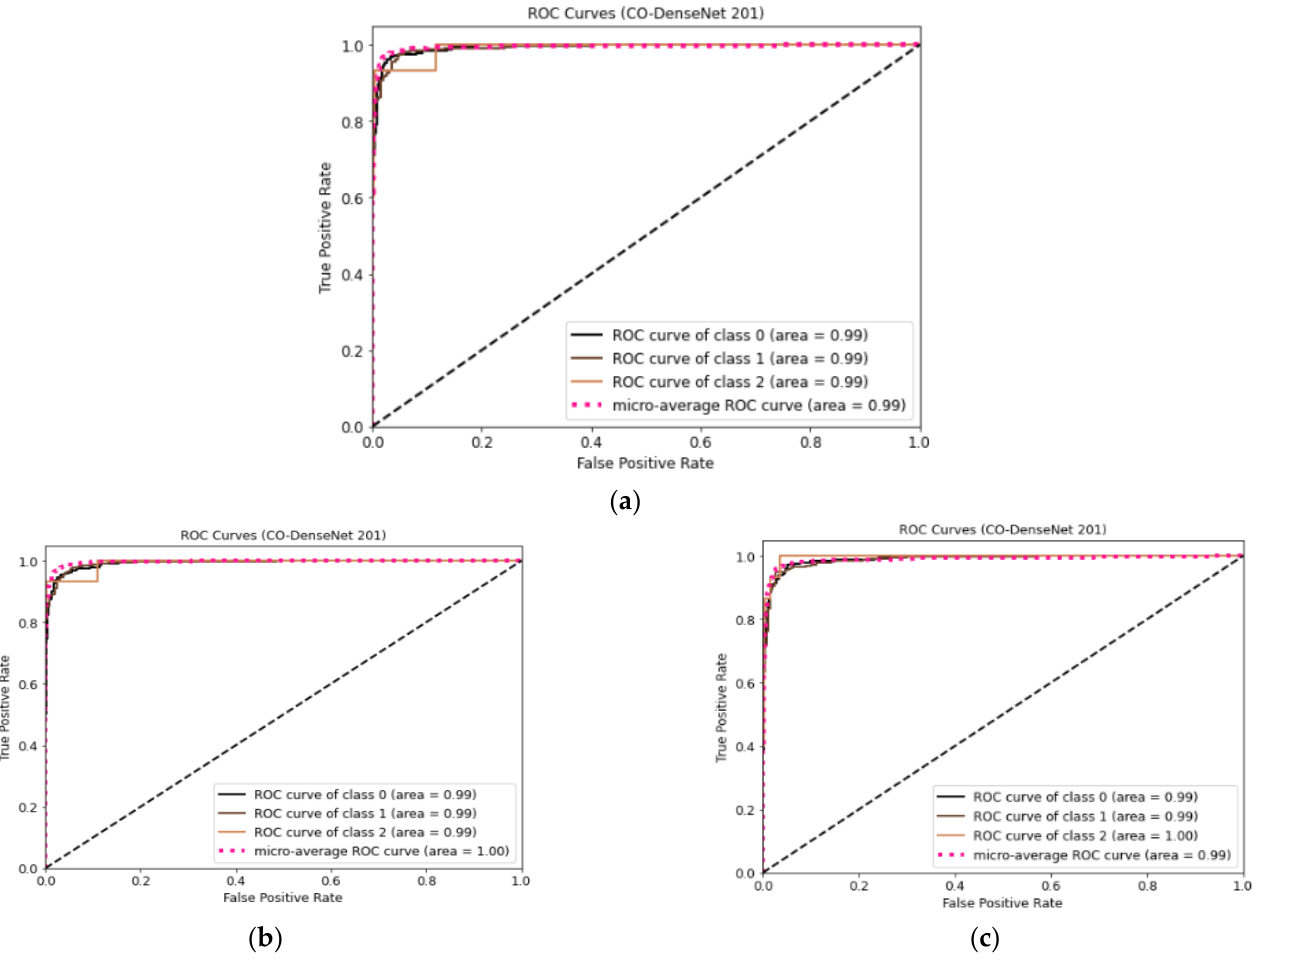
( c ) Figure 8. Confusion matrix for LDDNet: ( a ) Adam optimizer, ( b ) Nadam optimizer, and ( c ) SGD optimizer.